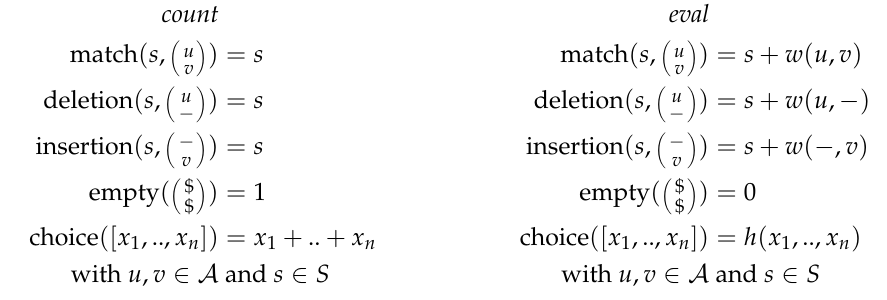
Figure 1. Two different scoring algebras written for the grammar of string alignment. Here, s ∈ R is the score, A the input alphabet, − the gap symbol and $ the empty string. The score contributions w ( ., . )